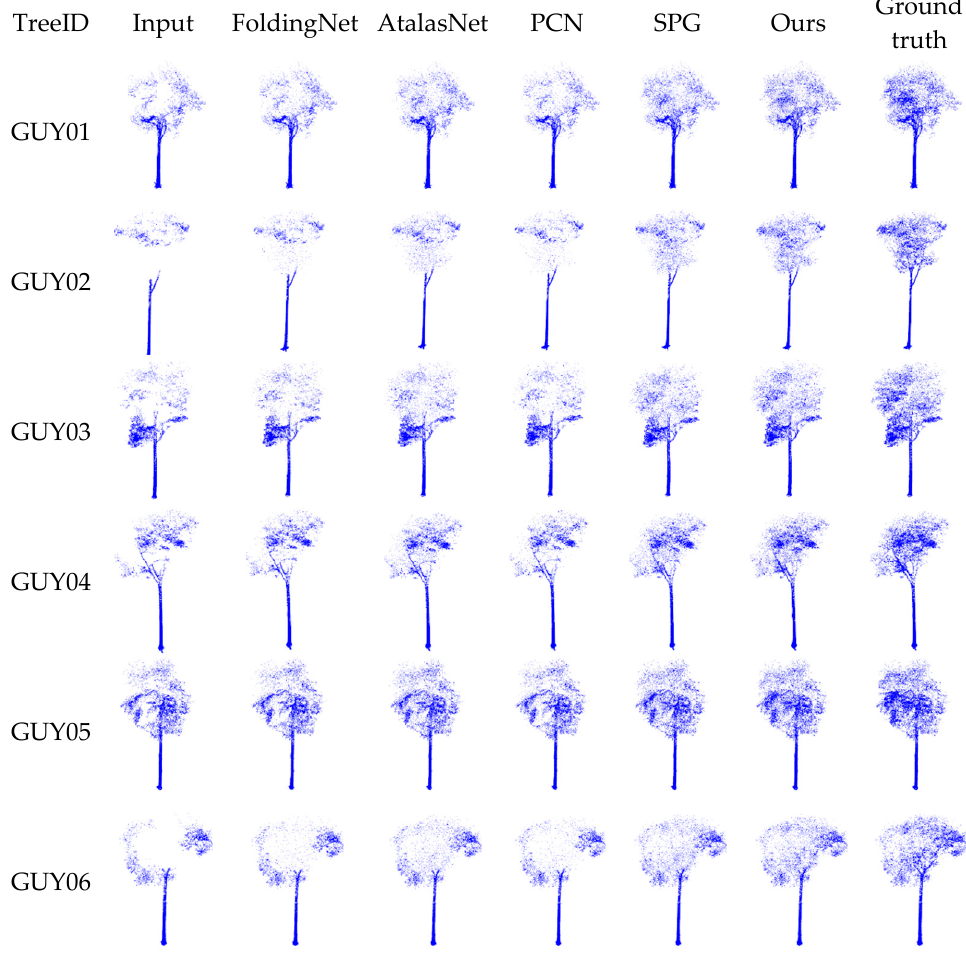
Figure 6. Visualization effect after point cloud completion of various